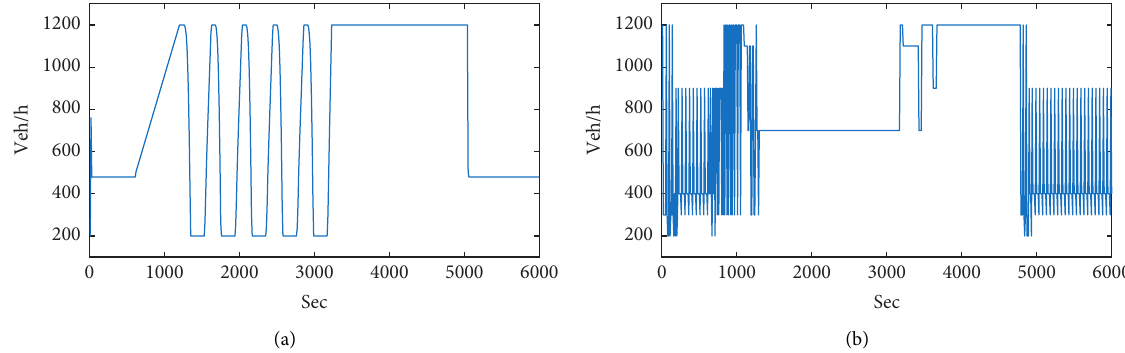
Figure 6: Comparison of ramp metering rates computed by the PI controller (a) and by the policy learned through the proposed approach